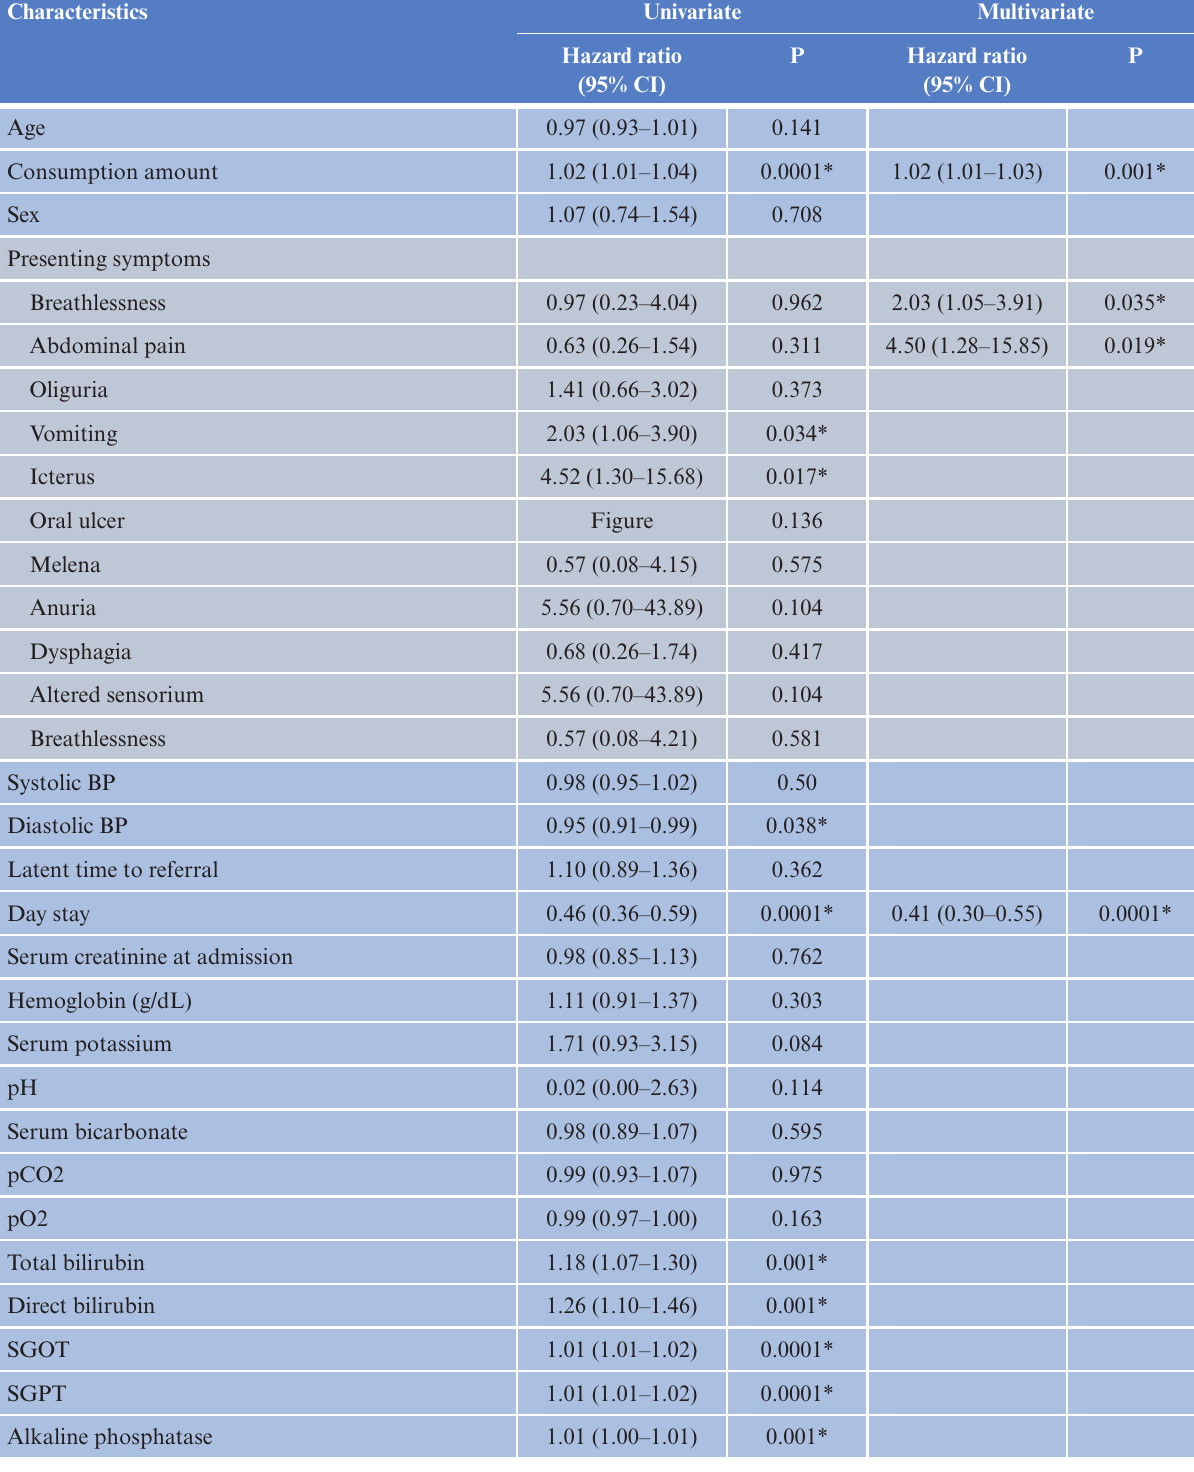
Table 4: Cox-proportional hazard regression